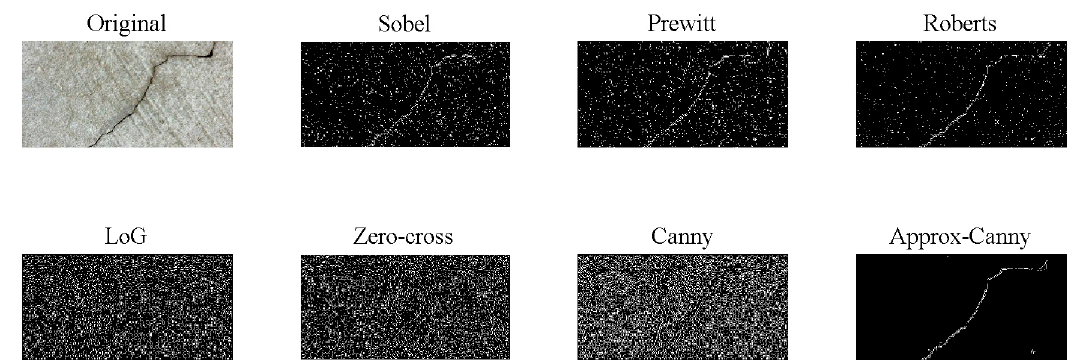
Figure 4. Concrete surface crack detection using different edge detection filters.